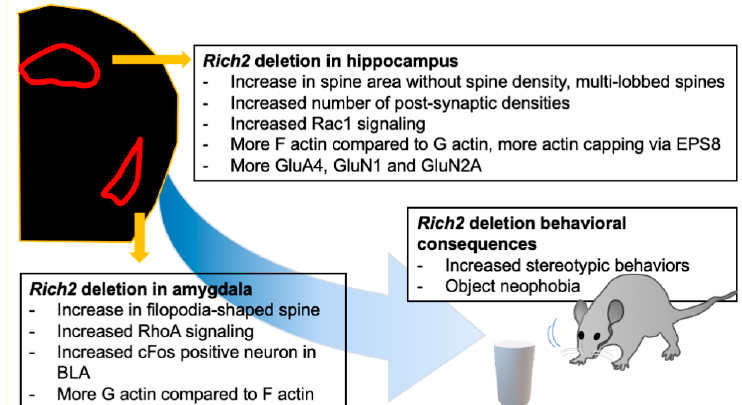
Figure 4. The effect of Rich2 deletion in different brain regions. Rich2 deletion affects different brain regions differently. Rich2 deletion increases stereotypic behavior and object phobia. Knock-out of Rich2 in the hippocampus shifts the spine morphology towards multi-lobbed spines, along with increased Rac1 signaling, whereas in the amygdala, the spines are shifted towards filopodia-shaped spines, along with an increase in RhoA signaling. There are also alterations in F and G actin equilibrium, immediate early gene expression, and synaptic signaling.